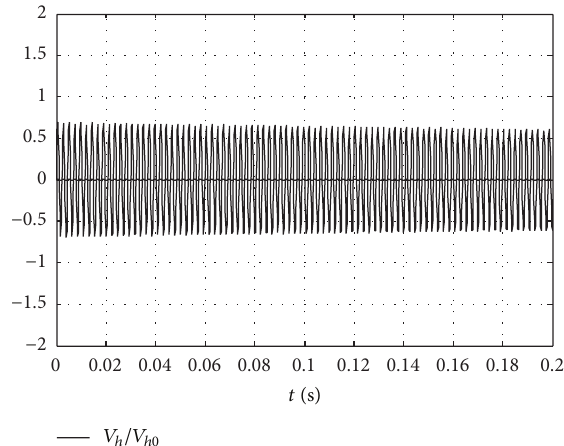
Figure 8: Velocity versus time plot of the generalized coordinate of the beam with piezoelectric attachment, 𝑅 = 0.01 , 𝜇 𝑥ℎ1 = 1 , 𝜇 V ℎ1 = 0.3 , 𝑈 = 95 m/s, and 𝑉